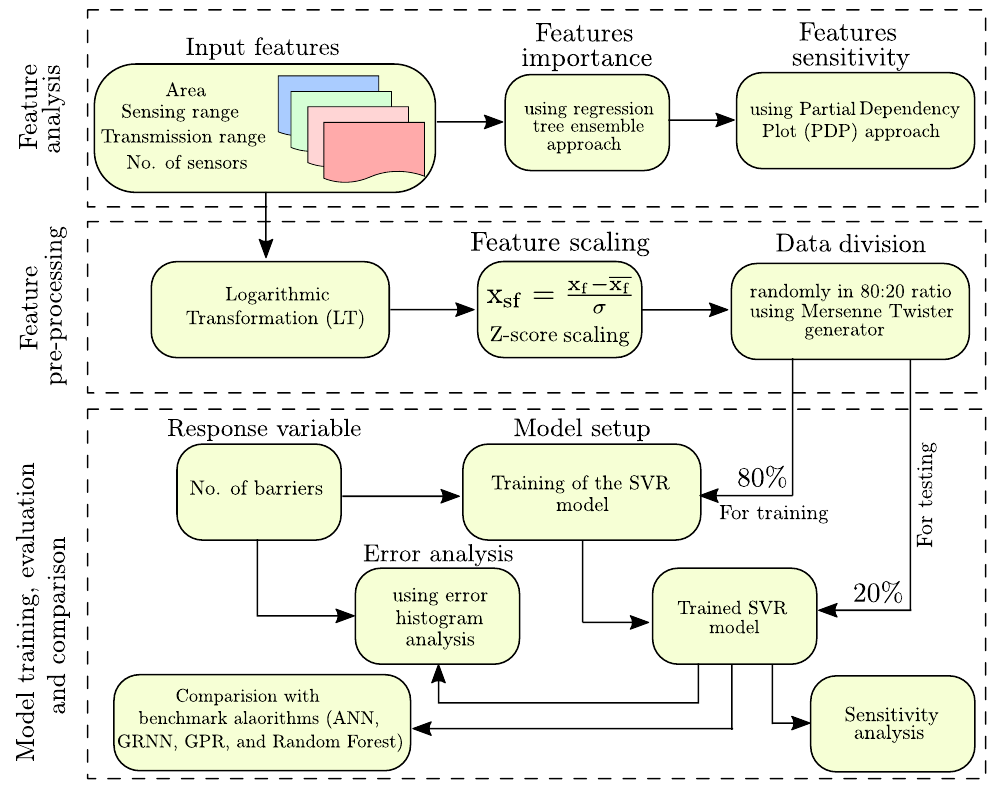
Figure 3. Flowchart of the proposed